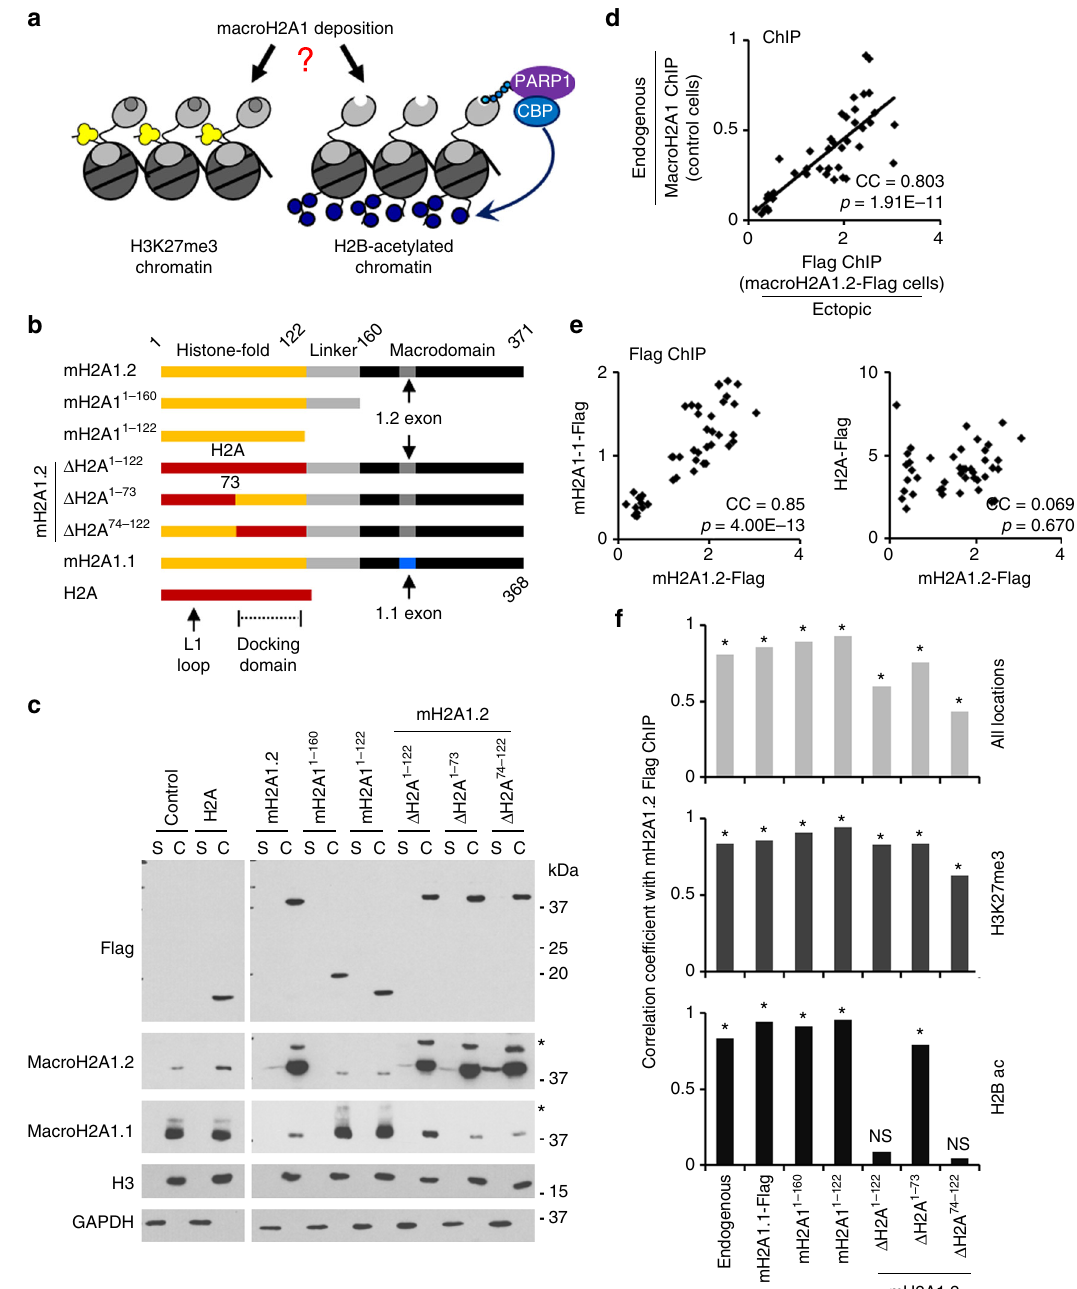
Fig. 1 MacroH2A1 requires the carboxyl-terminal half of its HFD for accurate deposition into H2B-acetylated chromatin. a Schematic depicting the different chromatin environments into which macroH2A1 is deposited marked by either H3K27me3 or acetylations at H2B K12, K15, K20, and K120. In H2B- acetylated chromatin, macroH2A1.1 cooperates with PARP1 through binding PAR to recruit CBP and regulate transcription. b Diagram of mutant macroH2A1.2-Flag (mH2A1) constructs expressed in IMR90-hTERT cells. The macroH2A1 alternative exons a nd docking domain are indicated. c Immunoblots of soluble (S) and chromatin (C) fractions from IMR90-hTERT cells described in b for indicated proteins. The minor band (*) above the major band in the macroH2A1.1 and macroH2A1.2 immunoblots is the mono-ubiquitylated species of macroH2A1. d Scatter plot of Flag ChIP from wild-type macroH2A1.2-Flag cells plotted against macroH2A1 ChIP from control cells expressing GFP ( n = 3 independent cell passages). Pearson ’ s correlation coef fi cient (CC) and associated p-value indicated are from Pearson ’ s product-moment correlation. e Scatter plot of Flag ChIP from wild-type macroH2A1.2- Flag cells versus Flag ChIP from H2A-Flag cells. ( n = 3 independent cell passages). f Pearson ’ s correlation coef fi cient calculated for Flag ChIP from wild- type macroH2A1.2-Flag cells versus vs. Flag ChIP from cells expressing macroH2A1.2-Flag truncations and domain swap mutants described in b . Top graph contains primers across both types or chromatin. Middle graph contains primers for regions marked with H3K27me3. Bottom graph contains primers for regions marked with H2Bac. ( n = 3 independent cell passages, * p < 0.003 from Pearson ’ s product-moment correlation, NS not signi fi